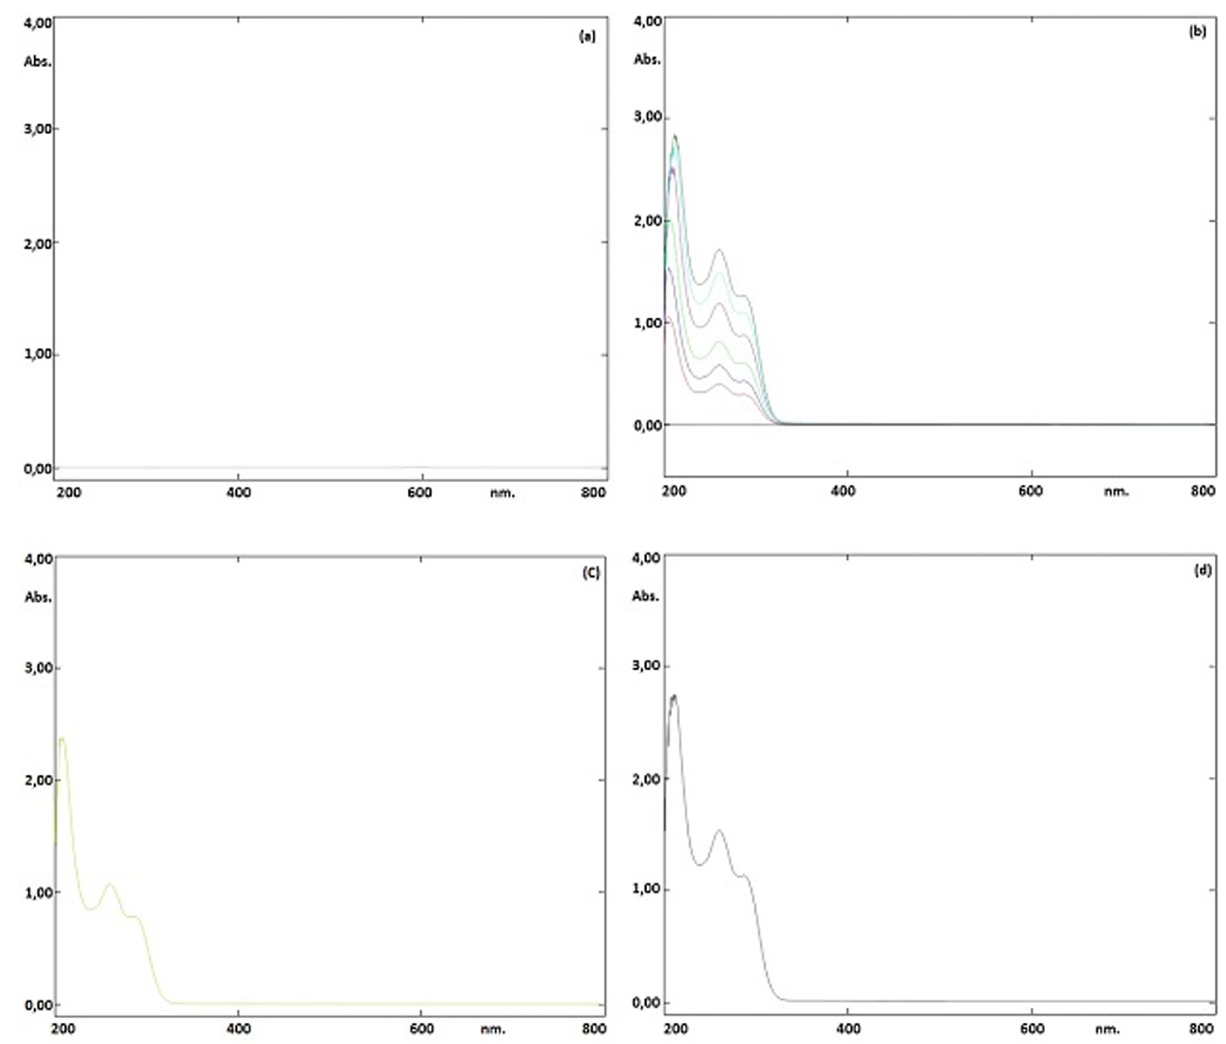
Figure 3: ( a ) UV spectrum of blank, ( b ) standard solutions ( 5 – 30 µg · mL − 1 ) , ( c ) pharmaceutical product ( 20 µg · mL − 1 ) , and ( d ) standard solution ( 25 µg · mL − 1 )